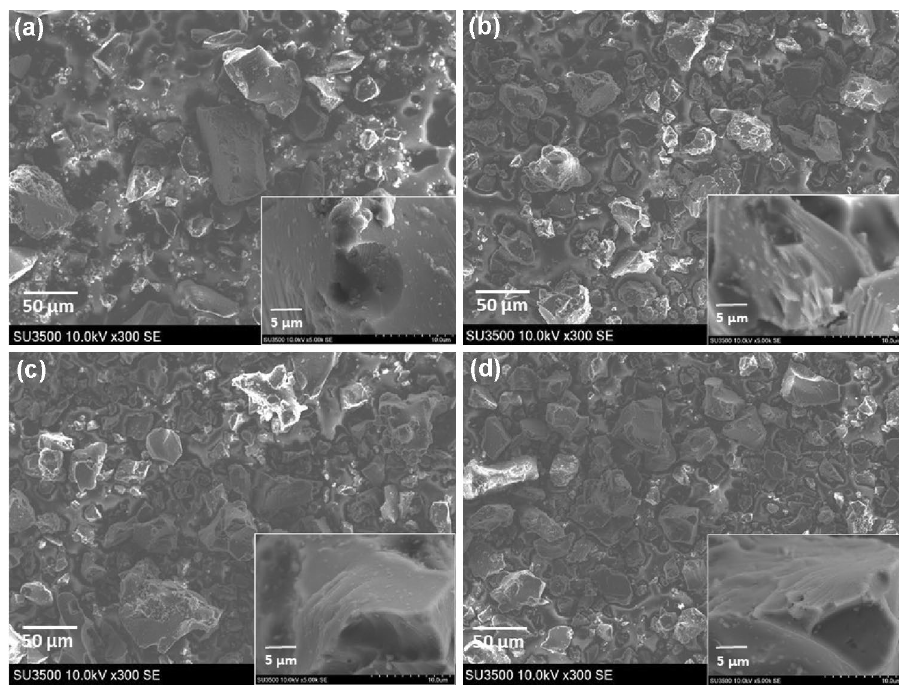
Fig. 4 SEM images of: a CFC;